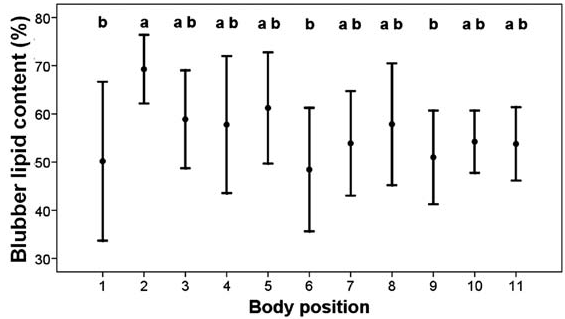
Fig. 4. – Mean and standard deviation of blubber lipid content (%) in the 11 body positions. The letters on top depict homogeneous statistical sub-grouping by Tukey